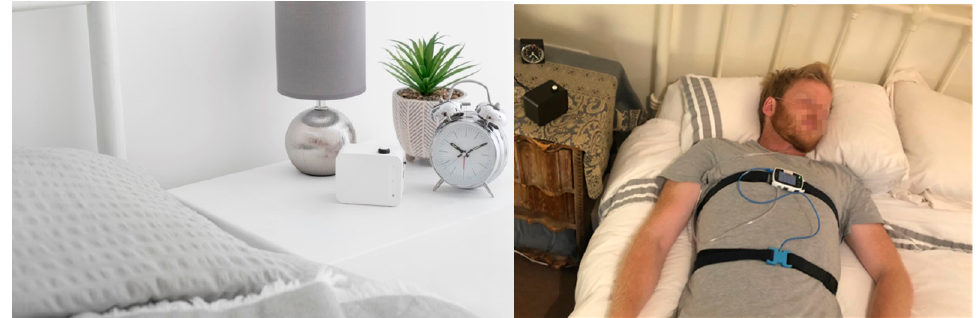
Figure 1. Image showing the Albus Home at the bedside ( left ) and the reference polygraphy device using thoraco-abdominal respiratory effort bands ( right ). For illustration, duvets were removed to show the device, but participants slept using own duvets under usual sleeping